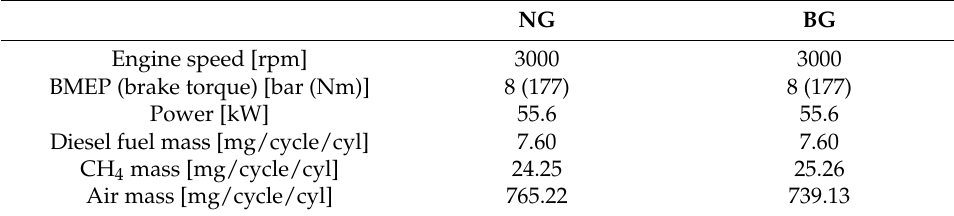
Table 4. Main engine parameters of the experimental validation case .